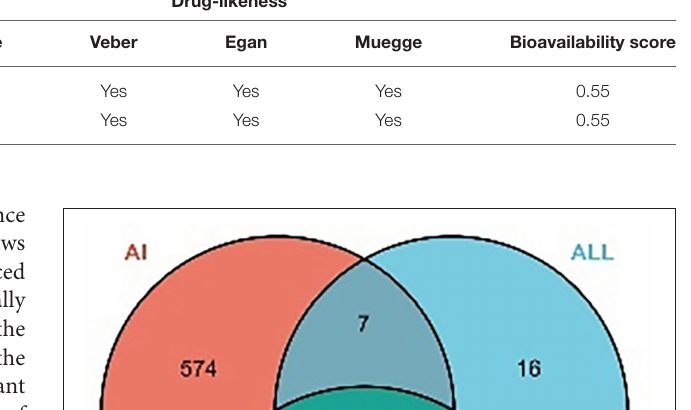
TABLE 4 | Pharmaceutical properties of active ingredients. Component